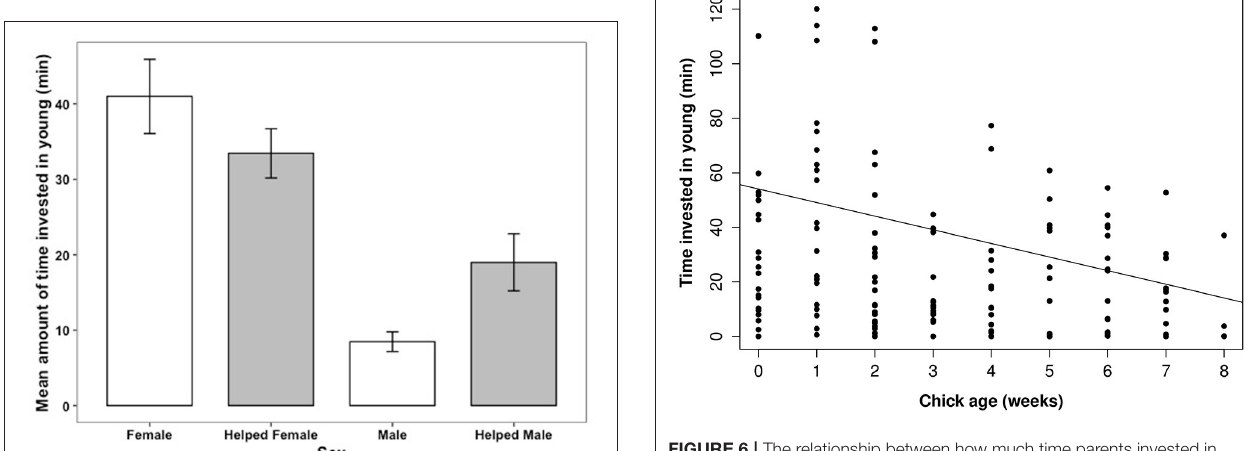
that variation in offspring care is influenced by an individual’s age, sex, foraging efficiency, group size, and the presence of